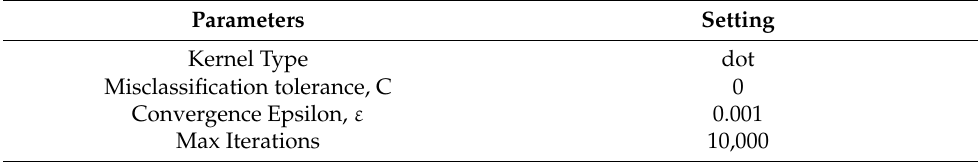
Table 2. Hyperparameters of the Support Vector Machine (SVM) model that considered for